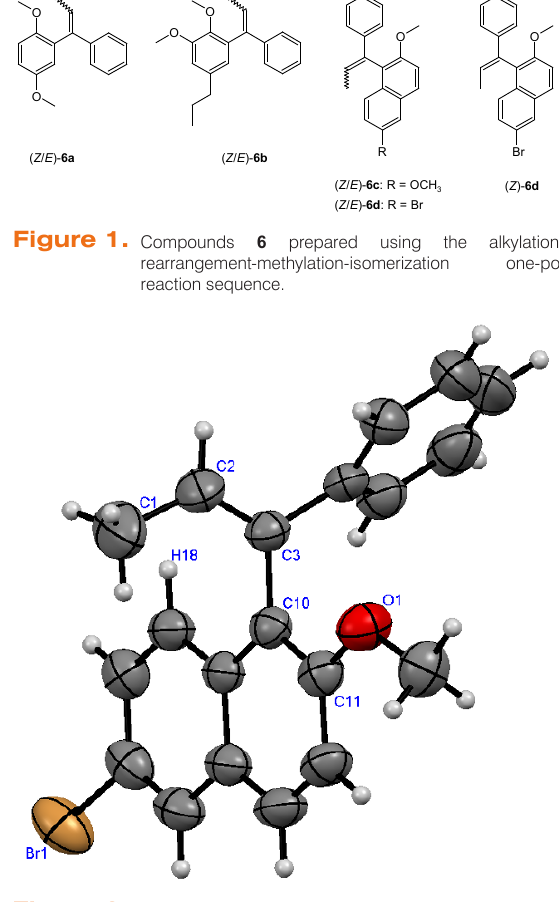
Figure 2. X-Ray crystal structure of (Z)- 6d .